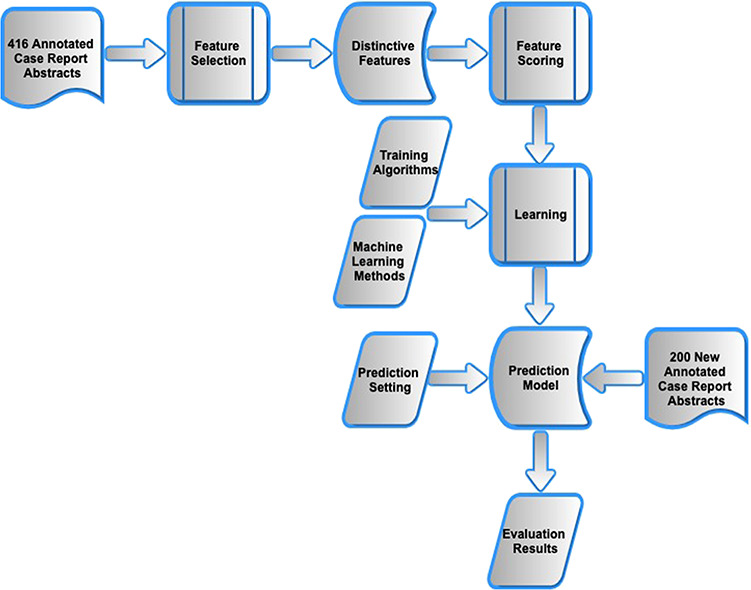
Workflow of methods.